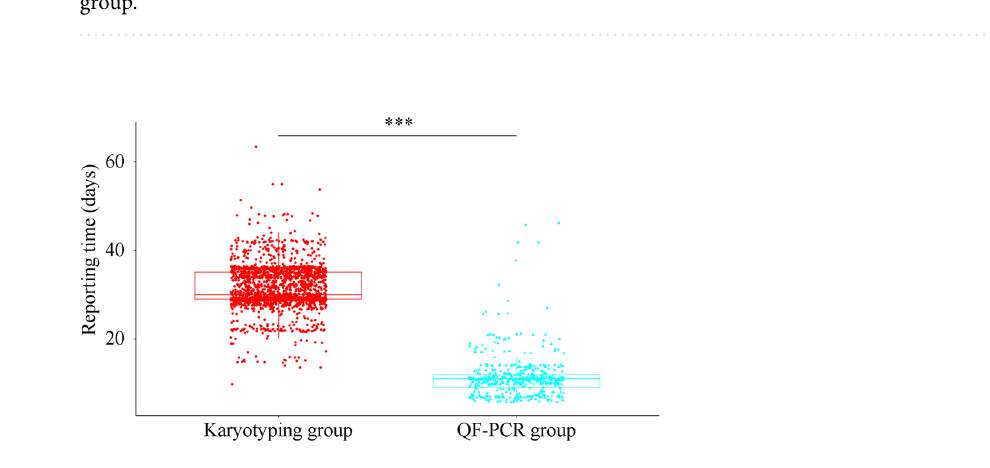
Figure 1. The reporting time of the karyotyping group and QF-PCR group. ***Represented a P <